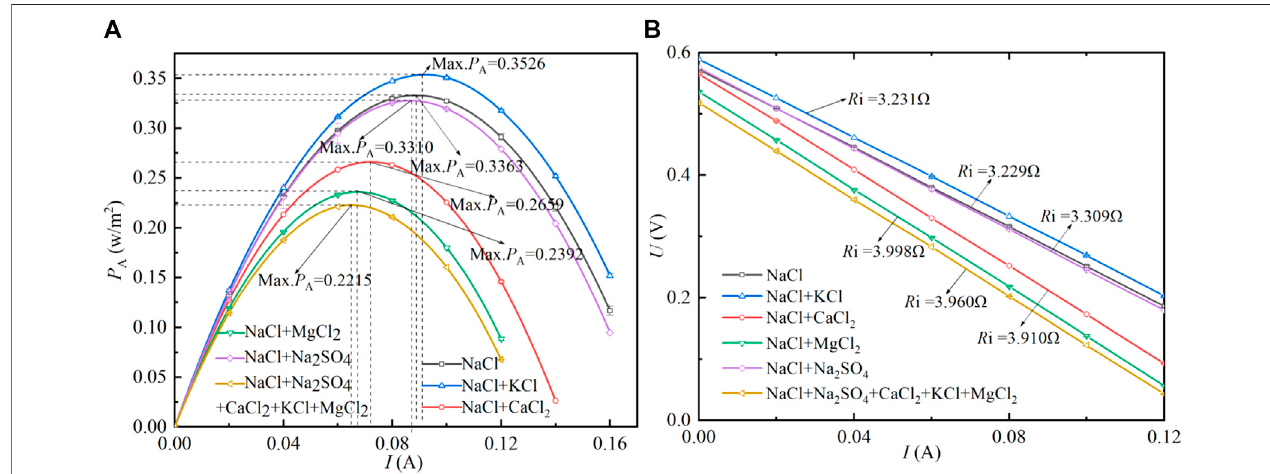
FIGURE 2 | Performance variation of the RED stack with the current. Feed temperature is set as 19 ° C, fl ow rate is 50 ml/min. 0.270 mol/L MgCl 2 , 0.055 mol/L CaCl 2 , 0.050 mol/L KCl, and 0.140 mol/L Na 2 SO 4 were added to 2.5 mol/L NaCl solution. 0.054 mol/L MgCl 2 , 0.011 mol/L CaCl 2 , 0.010 mol/L KCl, and 0.025 mol/L Na 2 SO 4 were added to 0.5 mol/L NaCl solution.